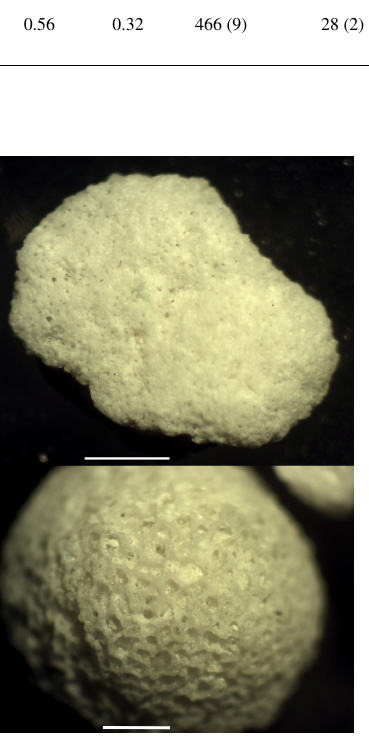
Figure 1. Images of carbonate grains from site 3 at Heron Island. Scale bar is